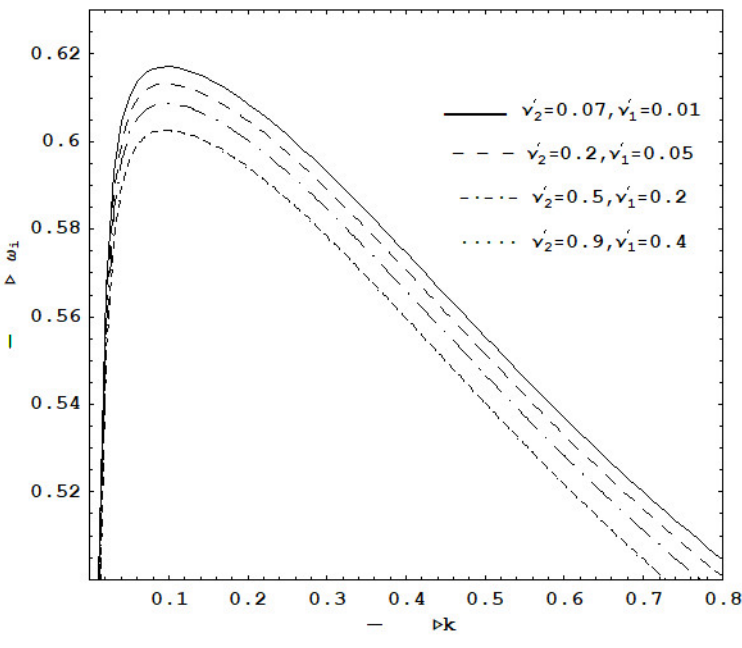
Figure 14. Variation of the growth rate ω i with the wavenumber k for different values of kinematic viscoelasticity ν (cid:48) , ν (cid:48) . 2 1